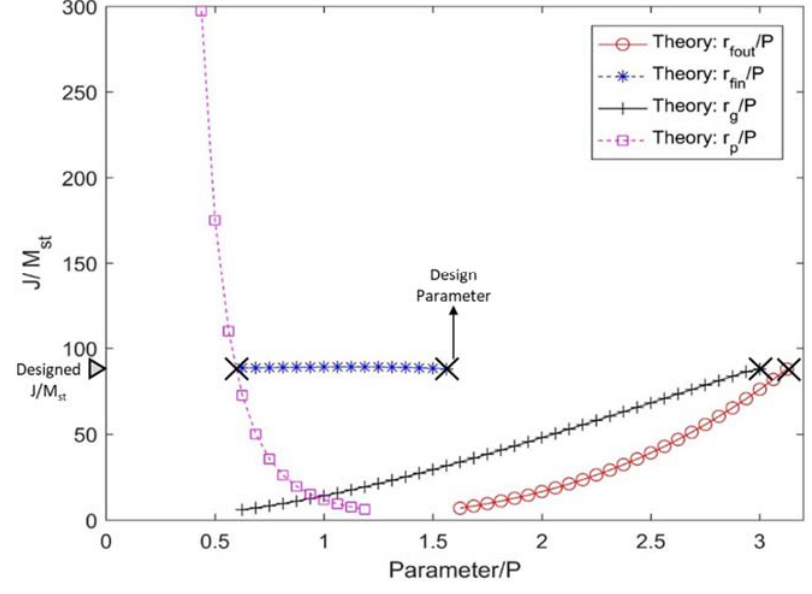
Figure 4. Parametric curves of the rack and pinion inerter. P is the pitch of the rack. Table 2. Key components of the rack ‐ and ‐ pinion inerter and values.